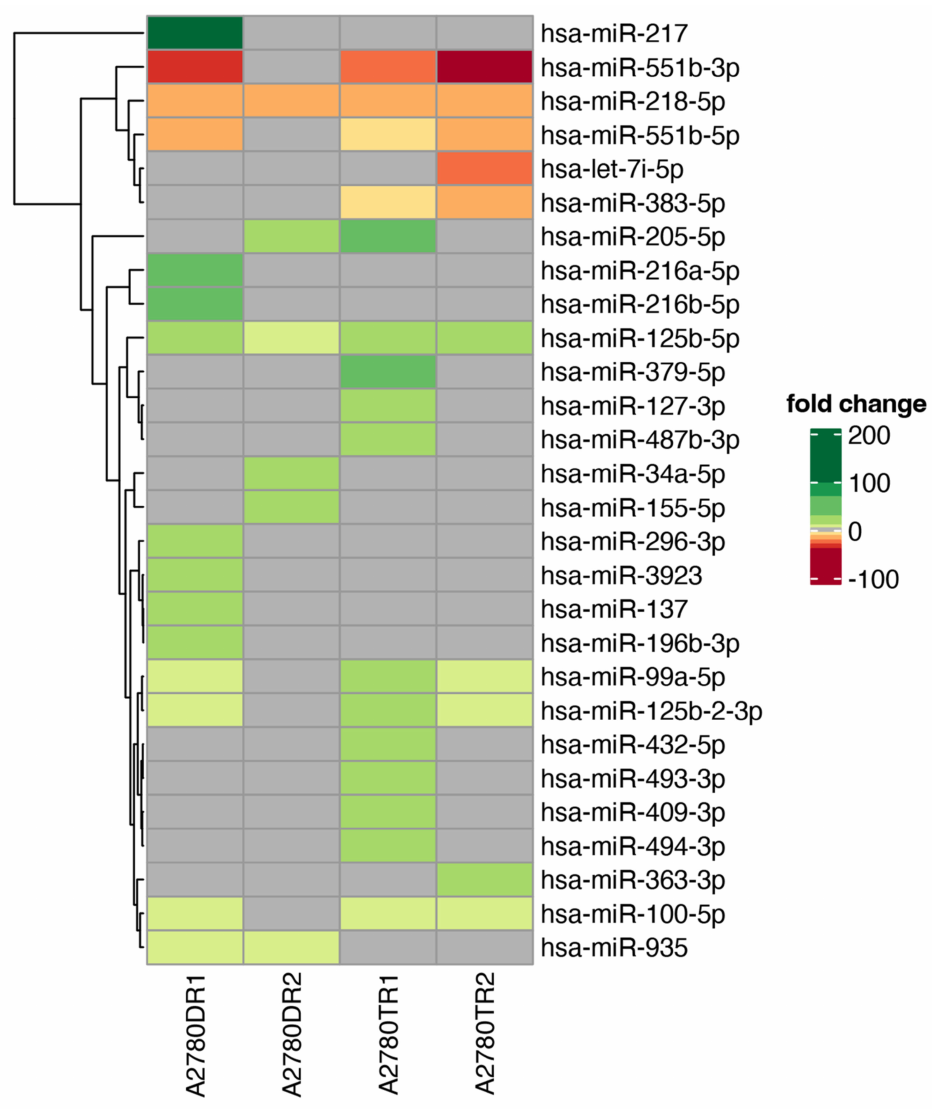
Figure 2. Heatmap with hierarchic clustering of miRNA expression ratios in drug-resistant sub- lines. Grey boxes correspond to genes below the cut-off criteria (|fold| < 5, p > 0.05). Differ- entially expressed genes were marked by color scale (up-regulated—light to dark green, down- regulated—orange to red). Expression change was calculated in relation to the A2780 cell